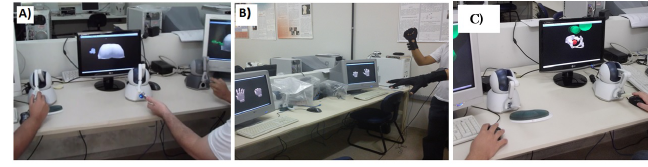
Fig. 5: Tutoring CVE with bidirectional tele-haptics, developed with CyberMed . The user at left controls the movements of other remote